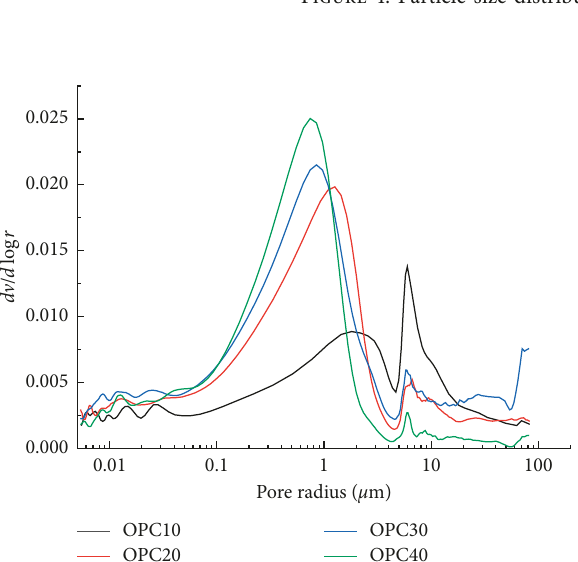
Figure 4: Particle size distribution of the solidified sewage sludge.